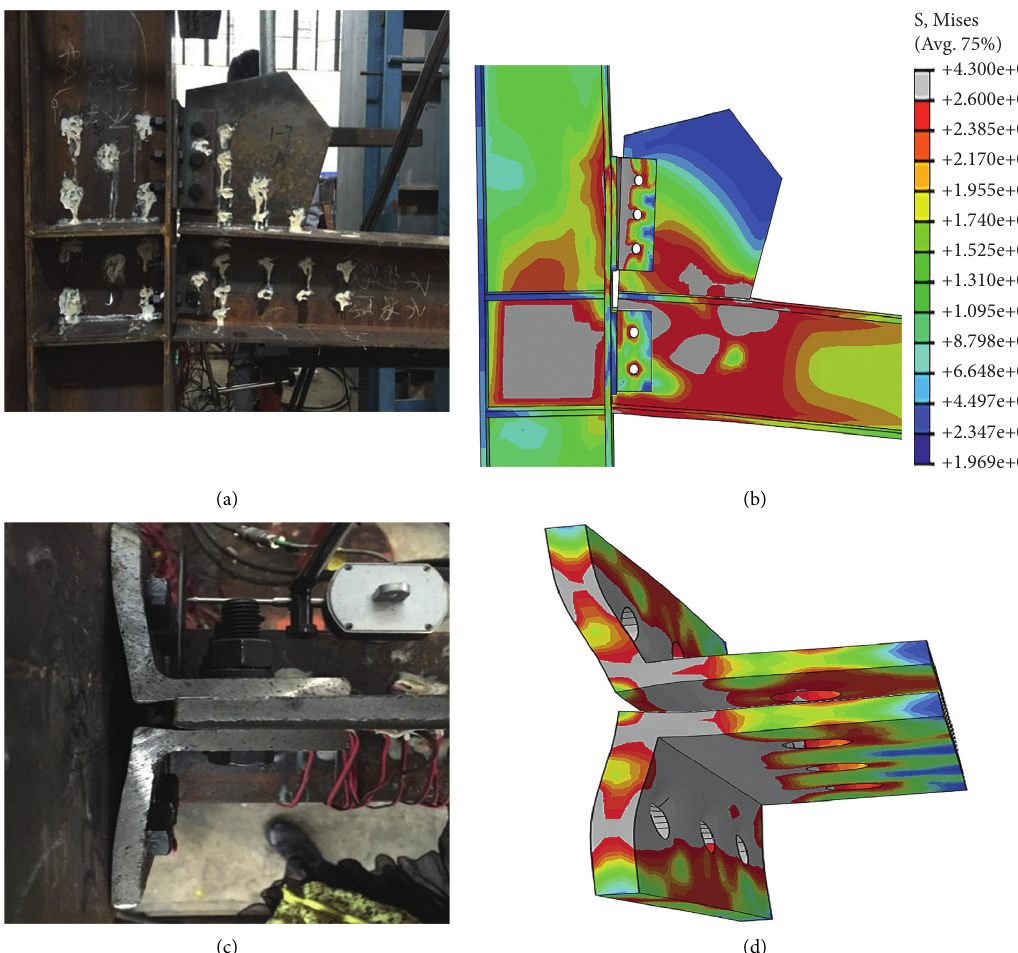
Figure 10: Comparison of ultimate failure states of SJA-1. (a) Overall test deformation. (b) Finite element deformation. (c) Gusset angle steel test deformation. (d) Gusset angle steel finite element